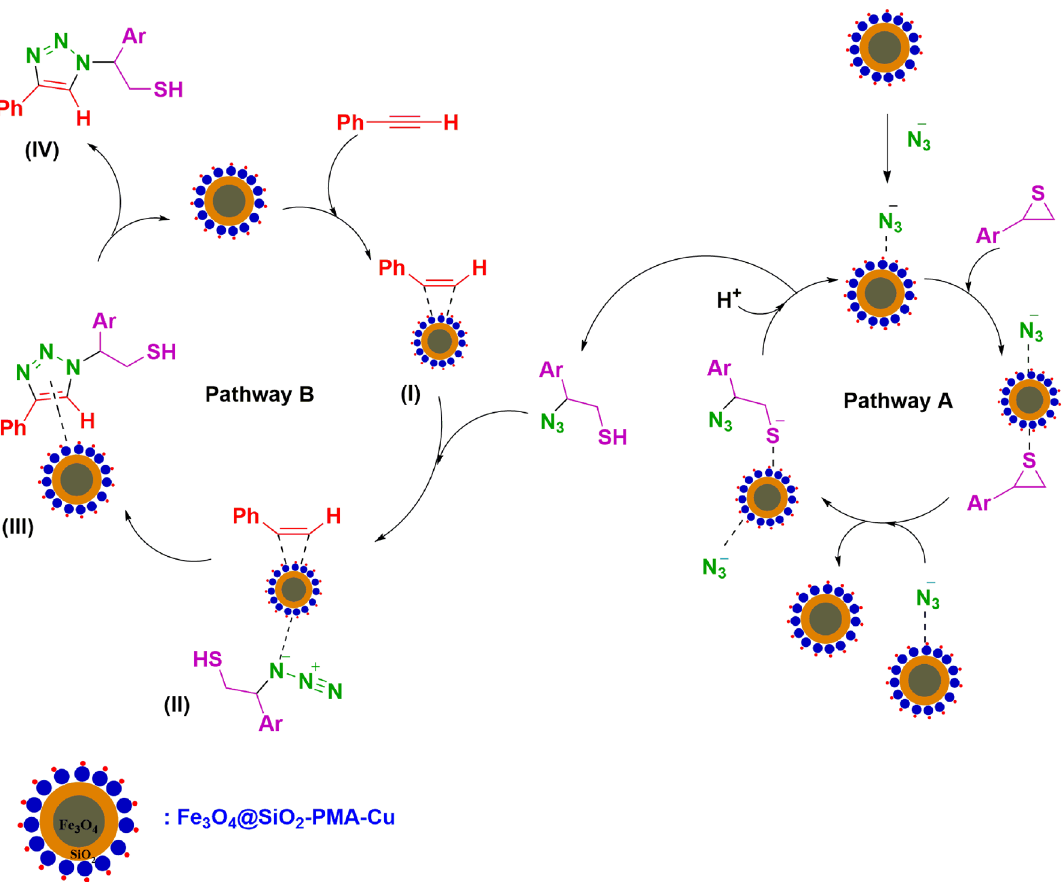
Figure 14. The proposed mechanism for the synthesis of β -thiol-1,4-disubstituted-1,2,3-triazoles in the presence of Fe 3 O 4 @SiO 2 -PMA-Cu